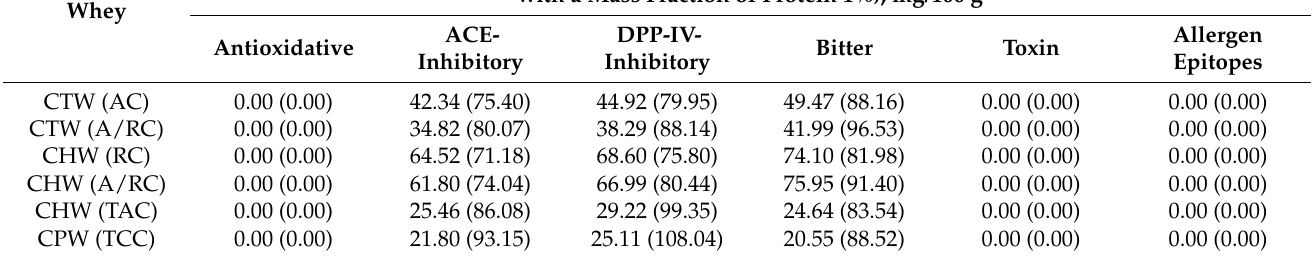
Table 8. Potential concentration of bioactive peptides in hydrolysates of different whey types after modeling of digestion in the gastrointestinal